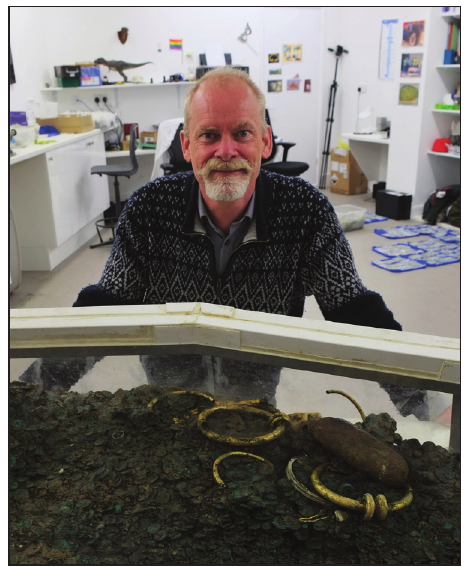
Figure 3: Neil Mahrer and the hoard (Photo: Neil